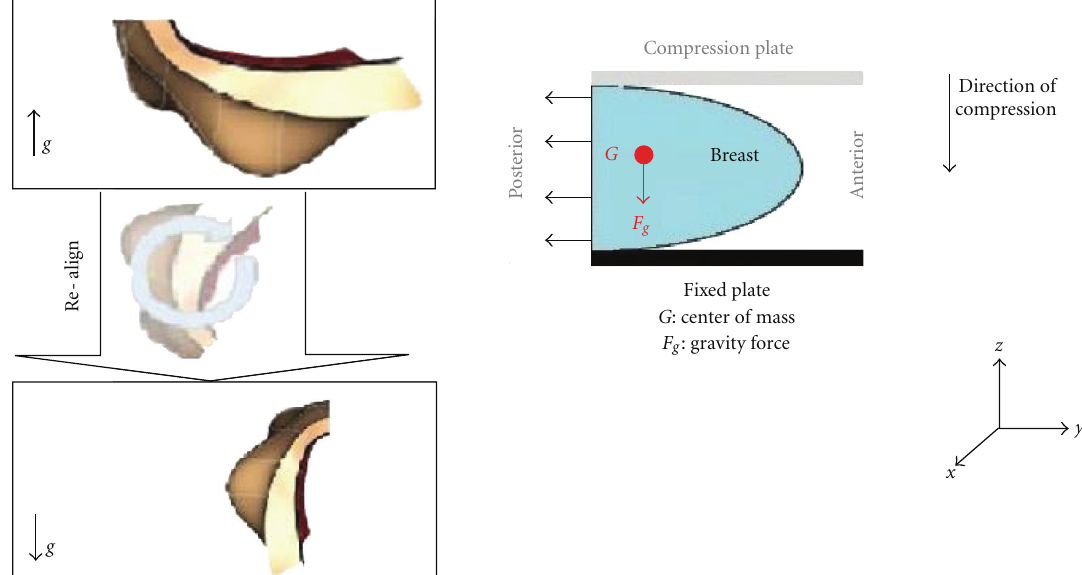
Figure 6: Boundary condition of the problem. Recovering the reference state when the patient is standing up (left) and boundary condition (right).